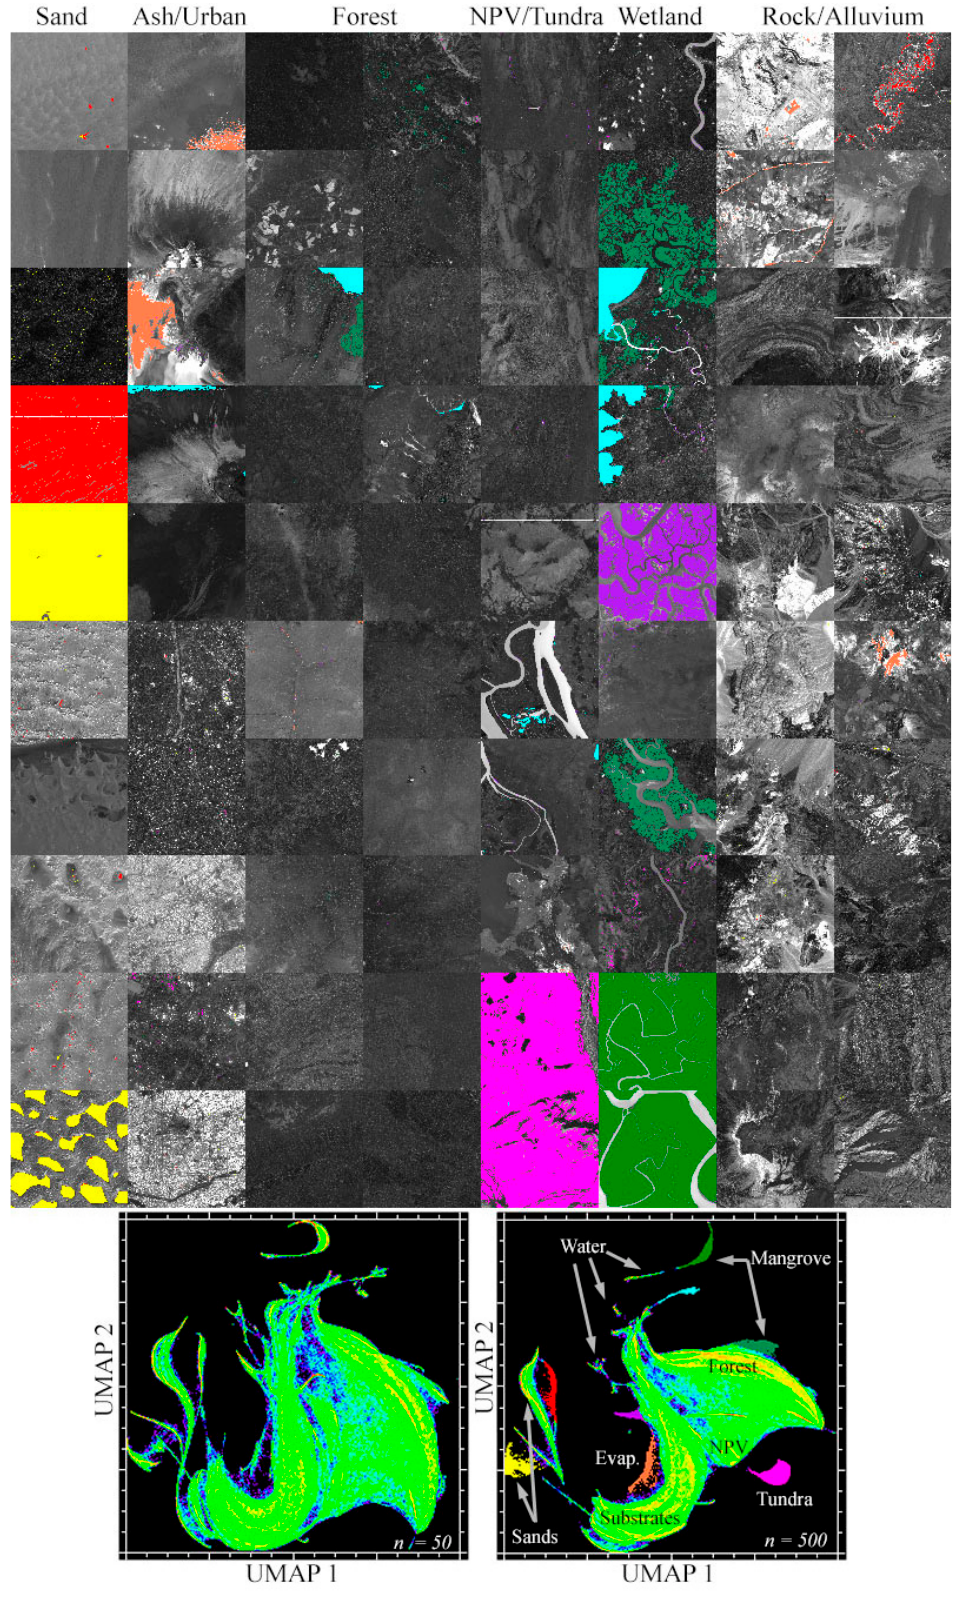
Figure 8. UMAP manifolds with distinct clusters labeled in mixing space then back-projected into geographic space (on RMS misfit map). Distinct clusters of spectra in the mixing space correspond to geographically distinct and spatially contiguous land